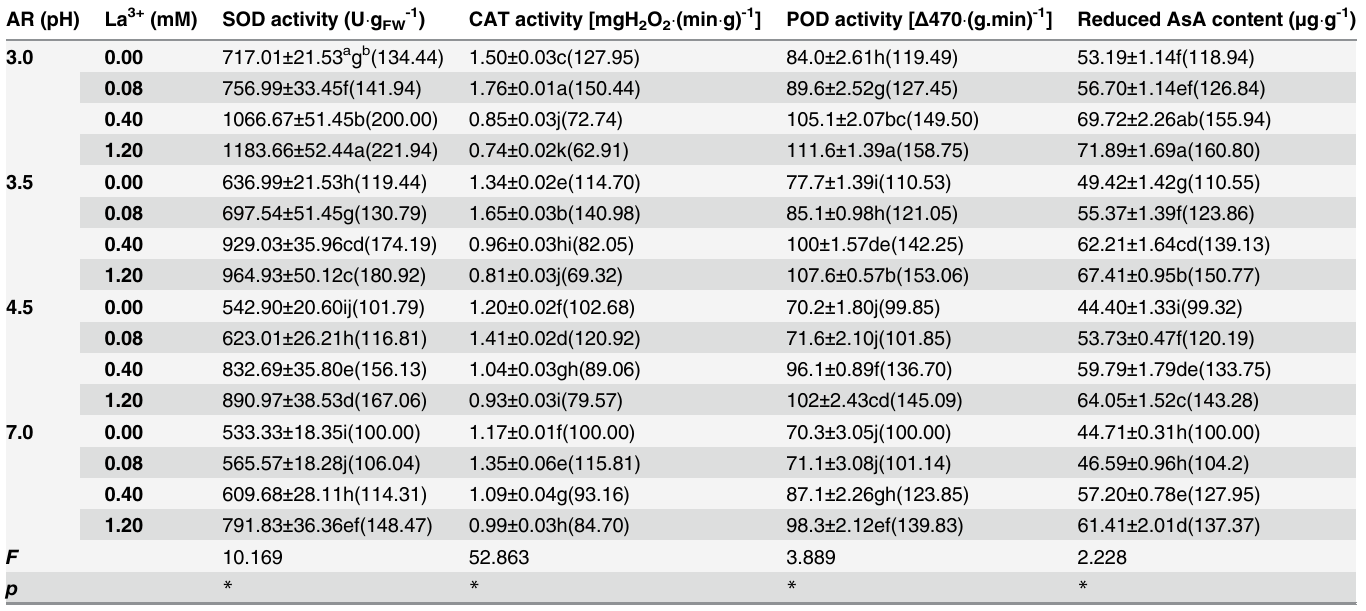
of La 3+ and AR. The results of two-way ANOVA indicated that there was an obvious interac- tion between La 3+ and AR that affected the contents of mineral elements in the roots and leaves (Table 5). The K, Ca content in the roots and leaves, and Mn content in roots positively corre- lated with the CAT activity (excepted for Ca in leaves), and negatively correlated with the SOD activity, POD activity, reduced AsA content and La content in the roots (Table 6). The Fe con- tent in the roots and leaves negatively correlated with the CAT activity (excepted for Fe in leaves), and positively correlated with the SOD activity, POD activity, reduced AsA content and La content in the roots (Table 6). The Mg content in the roots negatively correlated with the POD activity, reduced AsA content and La content (Table 6). The Cu content in the leaves positively correlated with the CAT activity (Table 6). Table 3. Effects of La 3+ and AR on the SOD, CAT and POD activities and reduced AsA content in soybean roots. AR (pH) La 3+ (mM) SOD activity (U (cid:1) g FW-1